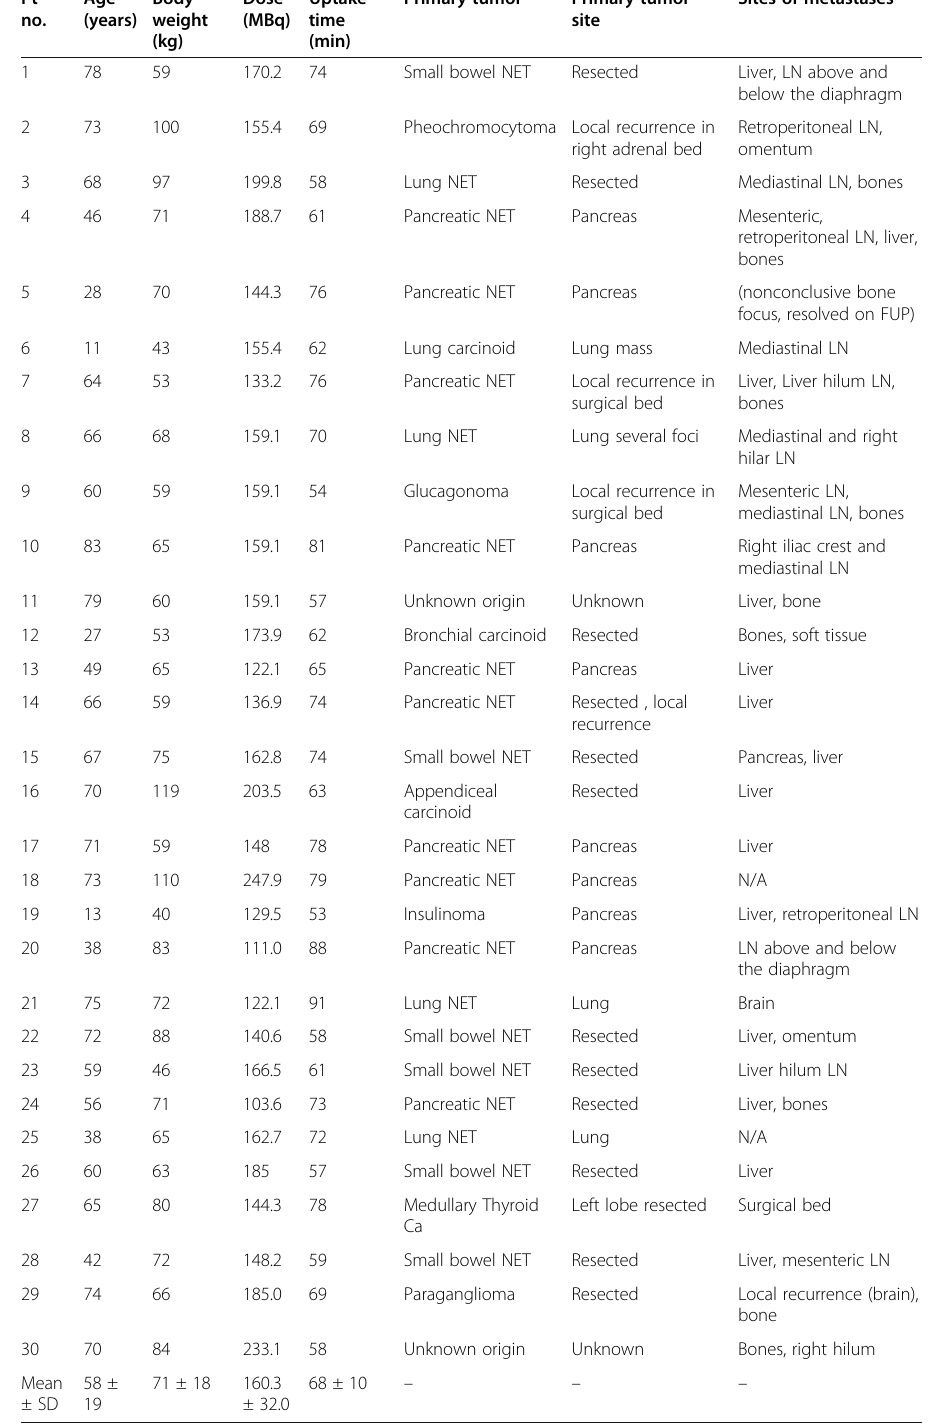
Table 1 Demographic data and patient